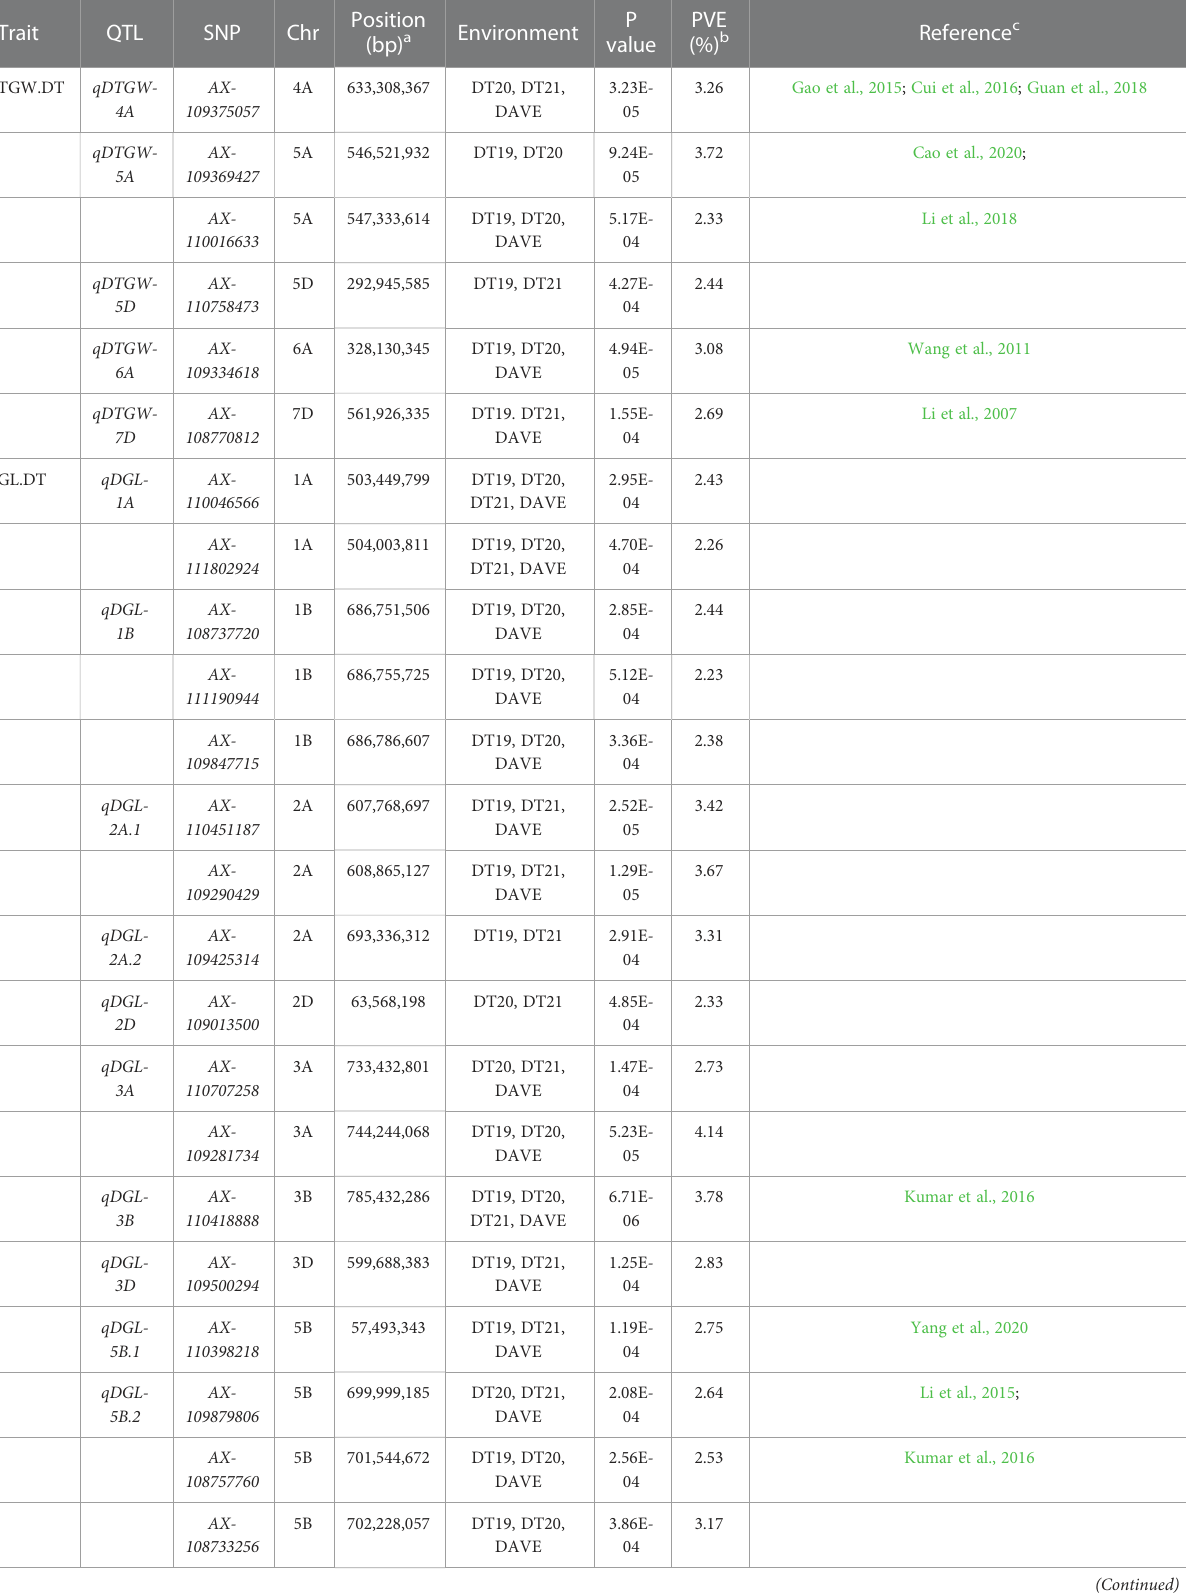
TABLE 3 The QTL and signi fi cant SNPs identi fi ed by GWAS for the yield-related traits under drought treatment (DT) conditions.